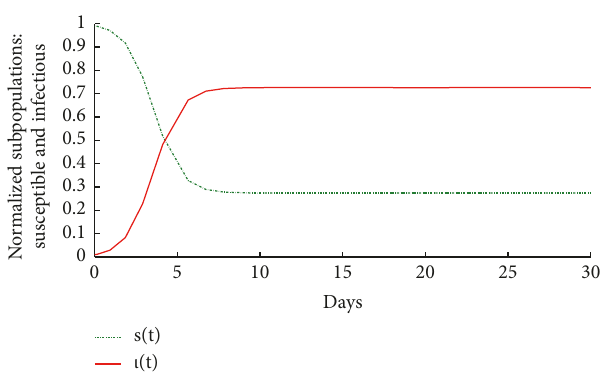
Figure 3: Zoom of Figure 2 in the first days of the transmission of the disease.